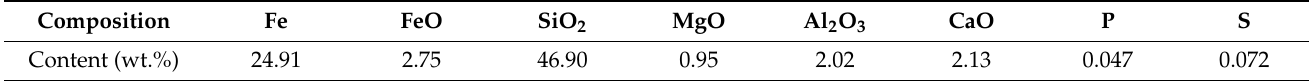
Table 1. Chemical elemental analysis of raw